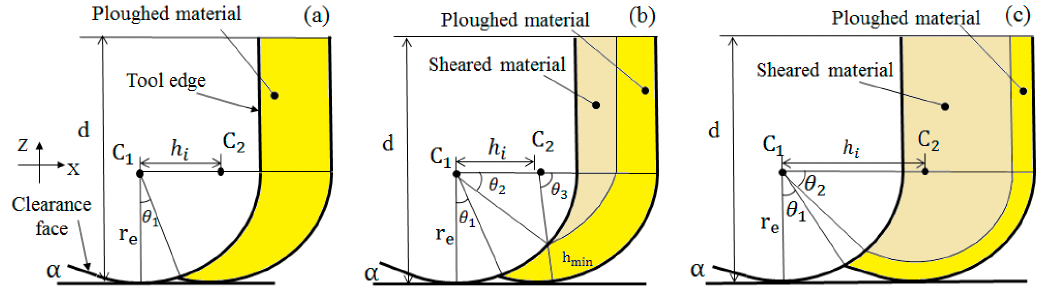
Figure 3. Geometry models of cutting regions at different uncut chip thicknesses with ( a ) a lower than minimum chip thickness; ( b ) a beyond minimum chip thickness without the influence of a clearance angle; and ( c ) an uncut chip thickness influenced by a clearance angle.